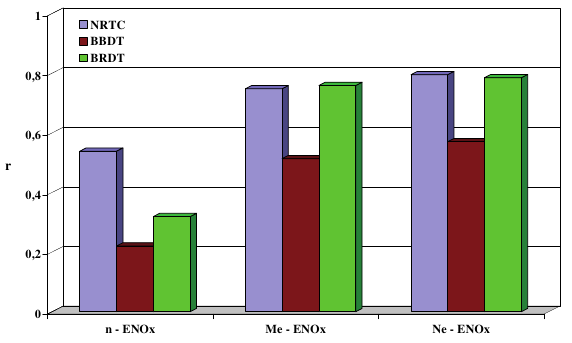
Fig. 20. The coefficient of Pearson’s linear correlation – r of nitrogen oxide emission intensity with engine speed, torque and effective